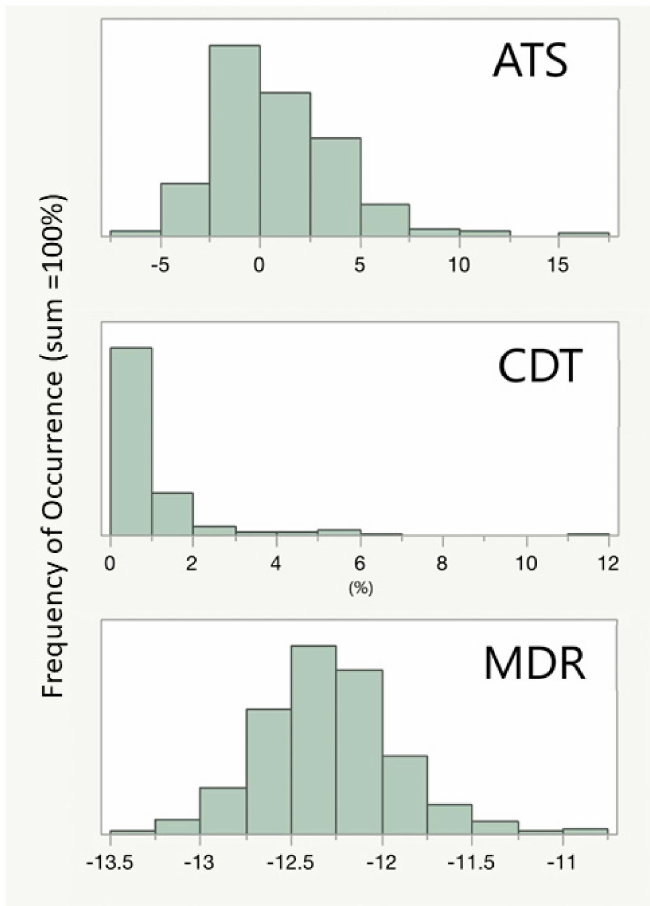
Figure 1. The distribution of the ATS, CDT and the MDR in the FACHS T population. Both the ATS and the MDR are unitless. The CDT is expressed as percent of total